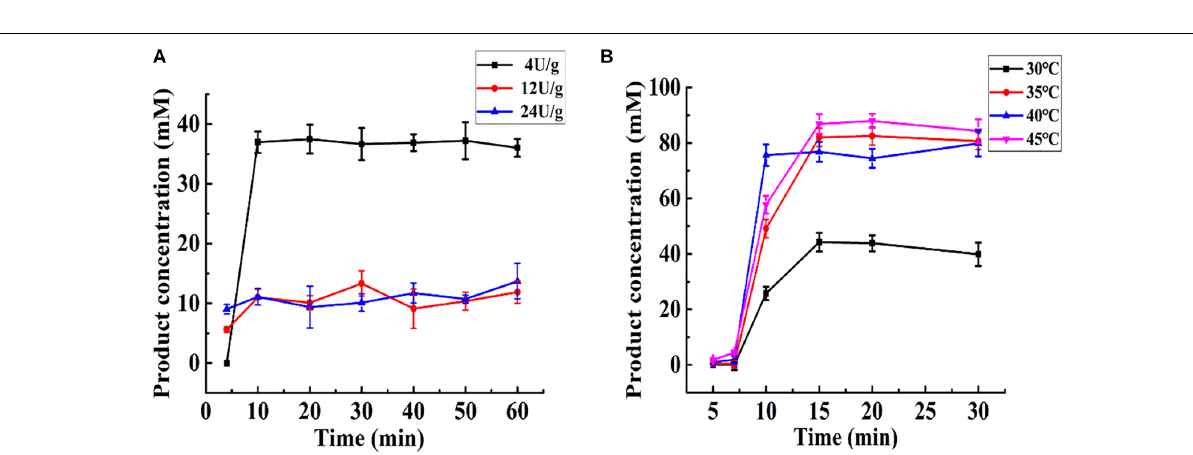
FIGURE 5 | (A) Effect of the specific activity of Aga-ASNase on catalytic efficiency of enzyme reactor. The effluent through the reactor from 0 to 60 min was collected and detected. (B) The effect of temperature on catalytic efficiency of enzyme reactor. The effluent through the reactor from 0 to 30 min was collected and